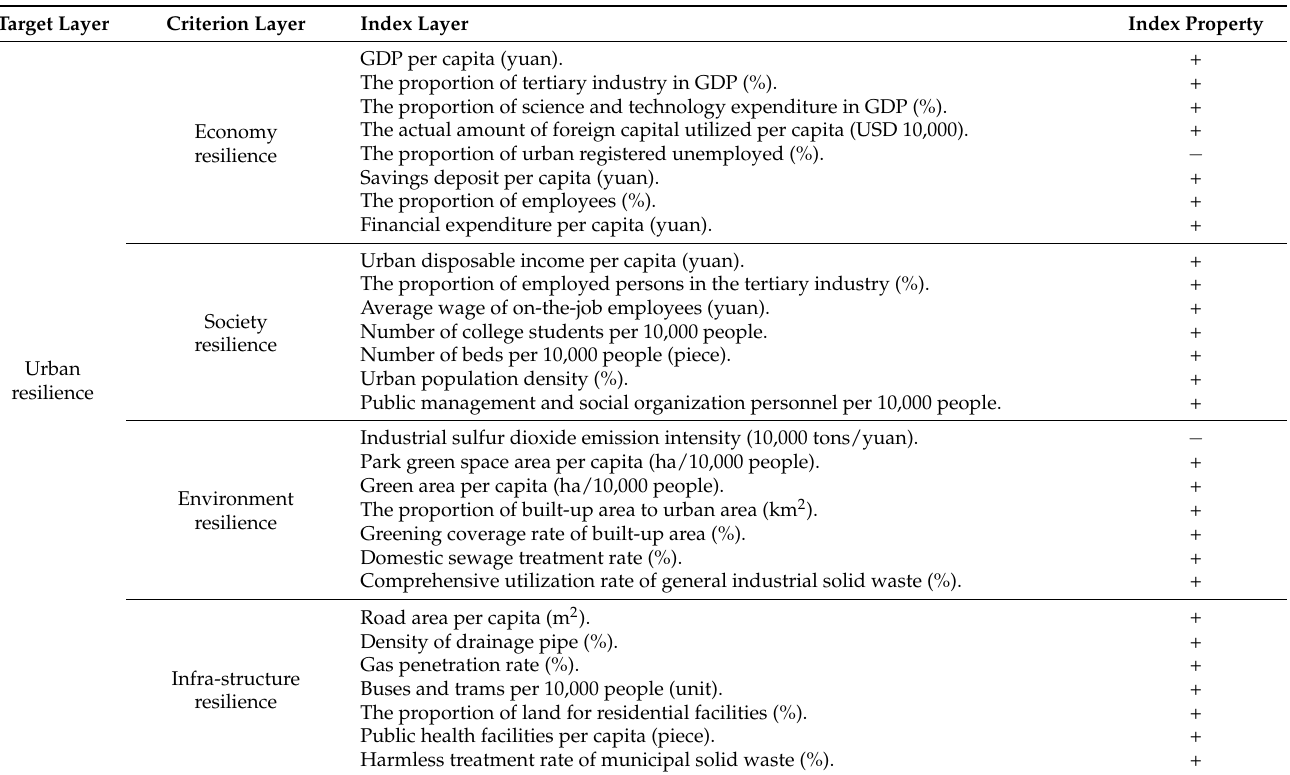
Table 1. Comprehensive evaluation index system of the urban resilience of eight urban